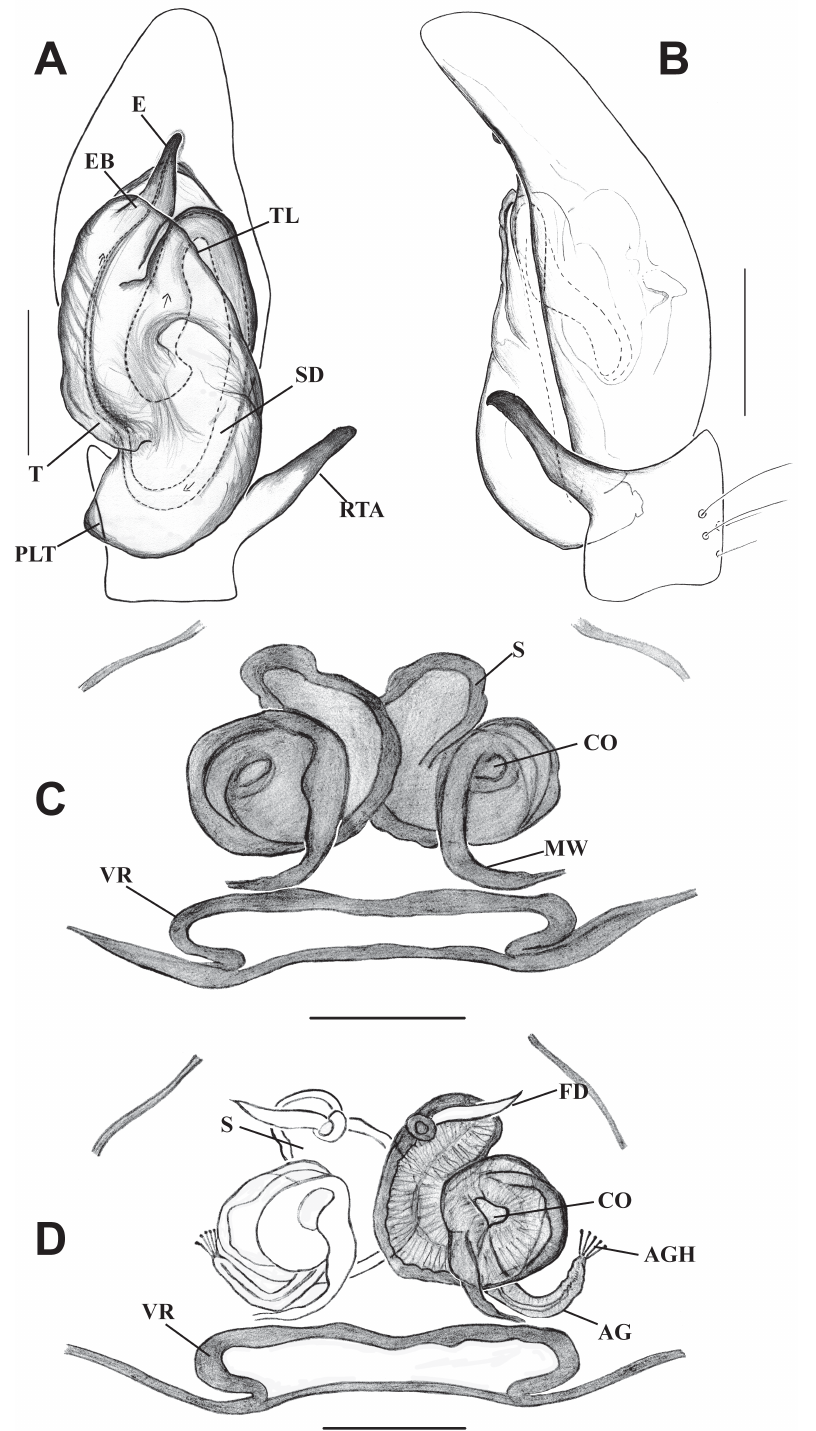
Fig. 6. Habrocestum hantaneensis sp. nov. A–B . ♂ (IFS_SAL 350). C–D . ♀ (IFS_SAL 456). A . Palp, ventral view. B . Palp, retrolateral view. C . Epigyne, ventral view. D . Vulva, dorsal view. Abbreviations: AG = accessory gland; AGH = accessory gland’s head; CO = copulatory opening; E = embolus; EB = embolic base; FD = fertilization duct; MW = membranous window; PLT = proximal lobe of tegulum; RTA = retrolateral tibial apophysis; S = spermathecae; SD = sperm duct; T = tegulum; TL = tegular ledge; VR = vaginal roof. Scale bars: A–B = 0.2 mm; C–D = 0.1